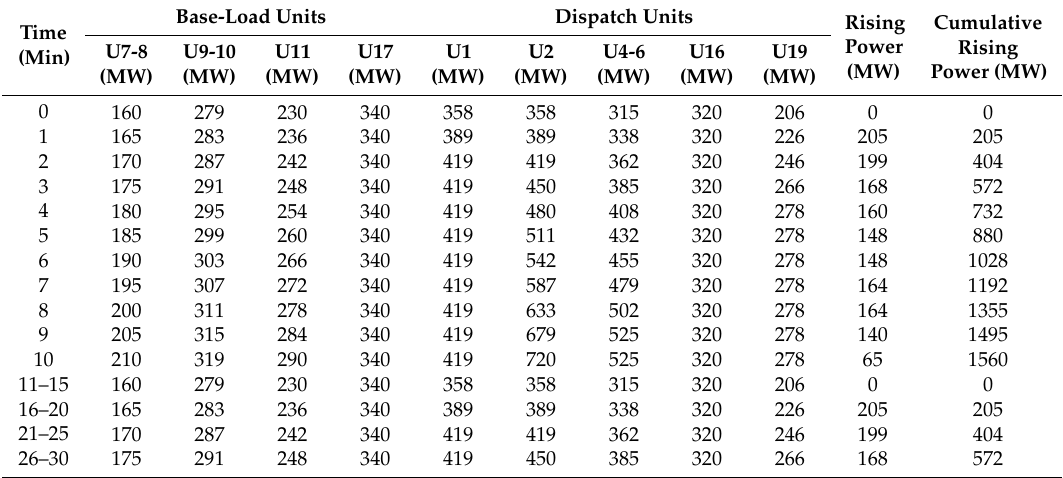
Table 7. The UC problem solved using the HA to increase power output by 1560 MW within 10